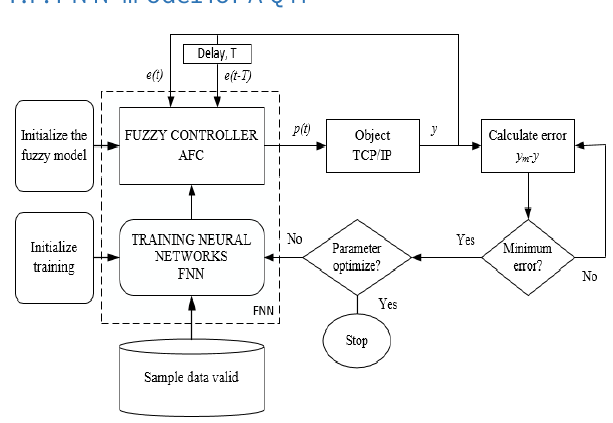
Figure 5. The model proposed FNN for AQM